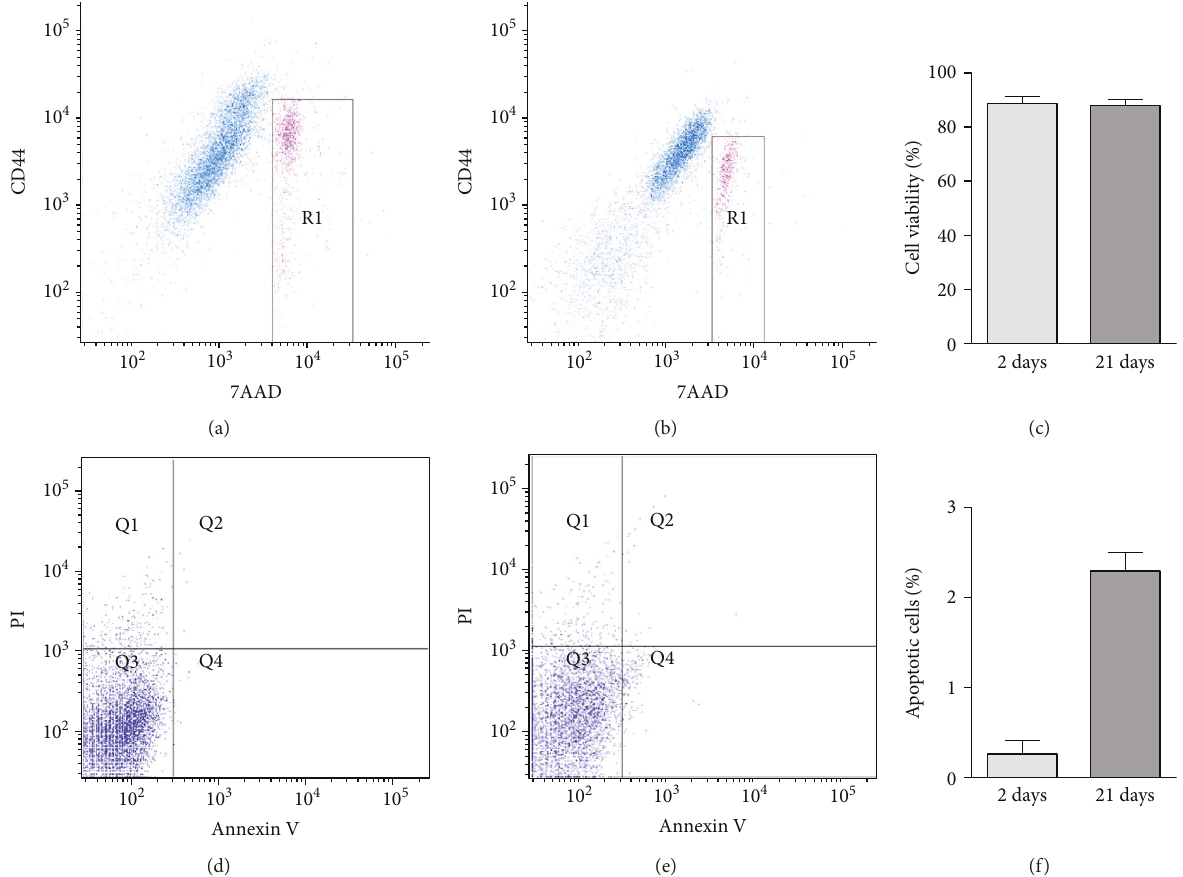
Figure 3: The CPC spheroids formed in the micromolded nonadhesive hydrogel with 800 μ m diameter in each circular recesses showed a high percentage of viability after spontaneous chondrogenesis. (a, b) Dot-plot graphs showing CPC positive for only CD44 in blue and double positive for CD44 and 7AAD in pink, after digestion of spheroids cultivated for 2 (a) and 21 (b) days. The viable cells were identi fi ed by 7AAD exclusion, outside the region R1. (c) The graph represents the percentage of viable cells in three di ff erent samples ( n = 3 ). (d, e) Dot-plot graphs of annexin V and PI evaluation showing CPC positive for annexin V in Q2 and Q4, after digestion of spheroids cultivated for 2 (d) and 21 (e) days. (f) The graph represents the percentage of apoptotic cells (annexin V positive cells) in three di ff erent samples ( n = 3 ). 7AAD: 7-actinomycin D; CD: cell cluster of di ff erentiation; PI: propidium